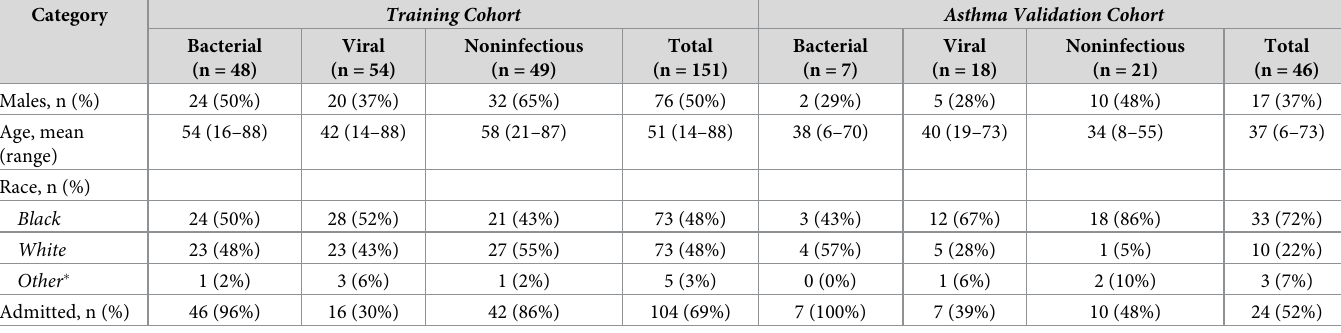
Table 1. Demographic information for the training and asthma exacerbation validation cohorts.